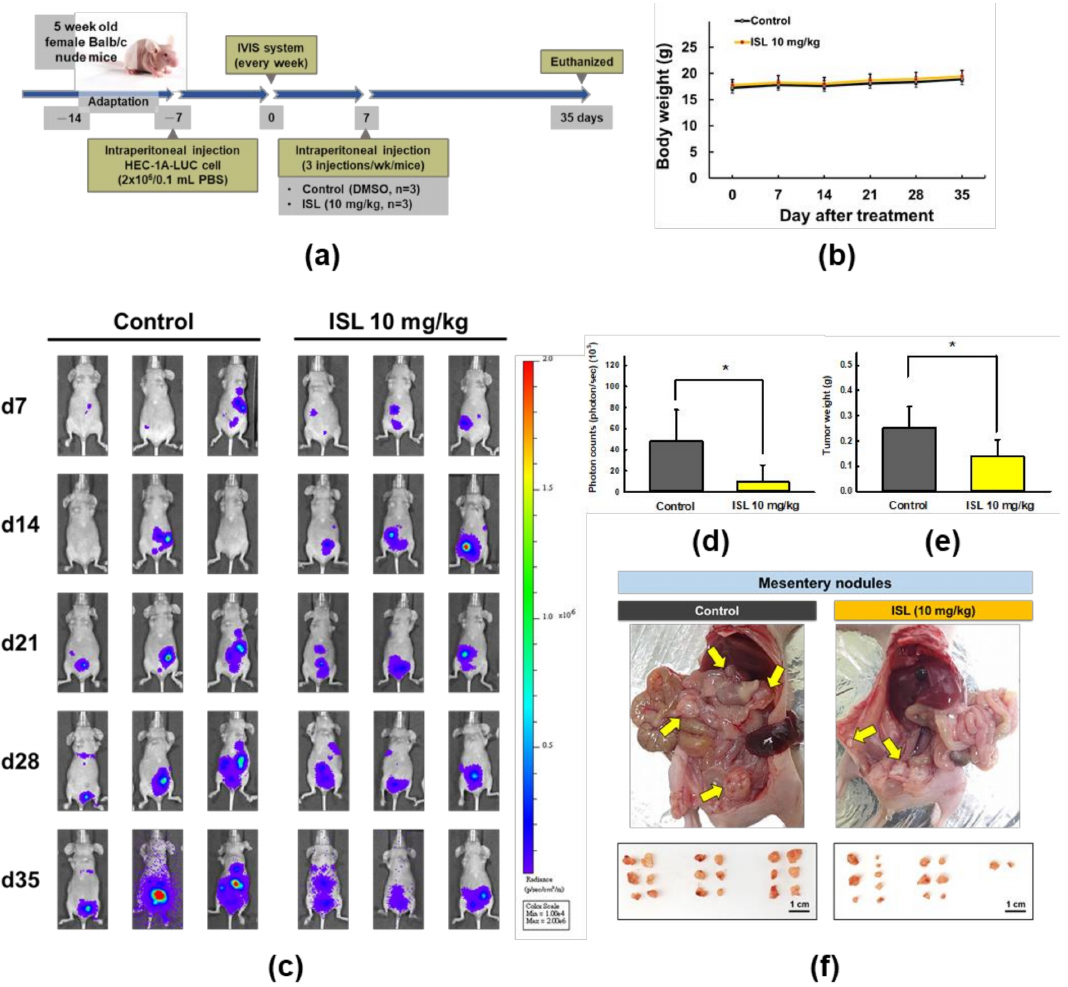
Figure 7. The effect of ISL on peritoneal dissemination in the HEC-1A-LUC mouse xenograft model. Tumors were implanted into mice via intraperitoneal injection of HEC-1A-LUC cells (2 × 10 6 cells/100 µ L PBS), and the mice were injected intraperitoneally with ISL (10 mg/kg) or control (DMSO) every 2–3 days for 28 days. ( a ) Schematic representation of the experimental plan. ( b ) Body weight of nude mice. ( c ) Total flux from luciferase imaging on day 7, 14, 28, and 35 after heterotopic tumor cell injection. ( d ) All luciferase images were normalized to the same photon saturation scale. ( e ) The weight of mesentery nodules and ( f ) nodule distribution state in abdominal cavity of nude mice. Data were expressed as the mean ± SD ( n = 3). * p < 0.05 versus the